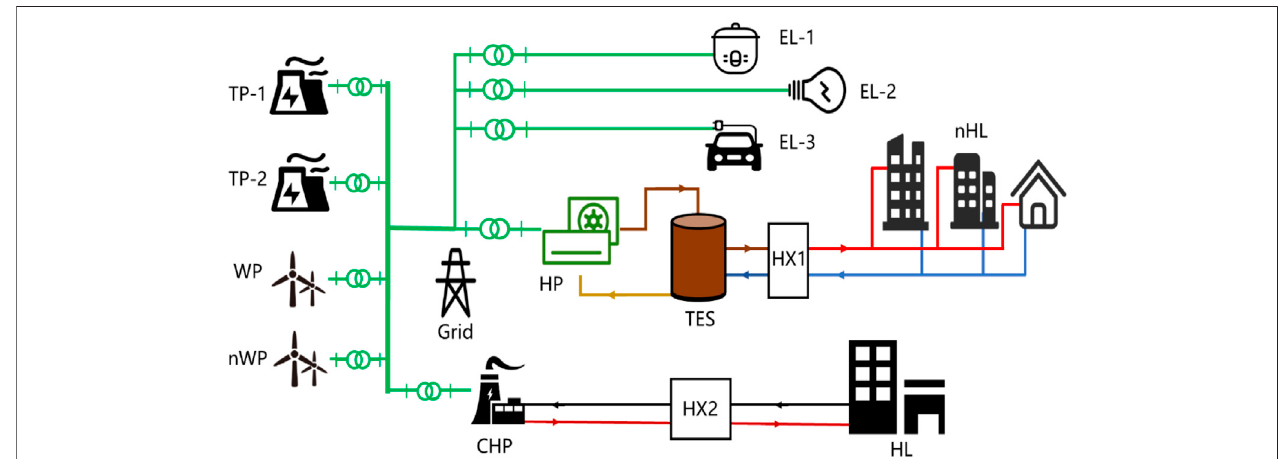
FIGURE 1 | Sketch of the IETEs with the heat pump – thermal storage